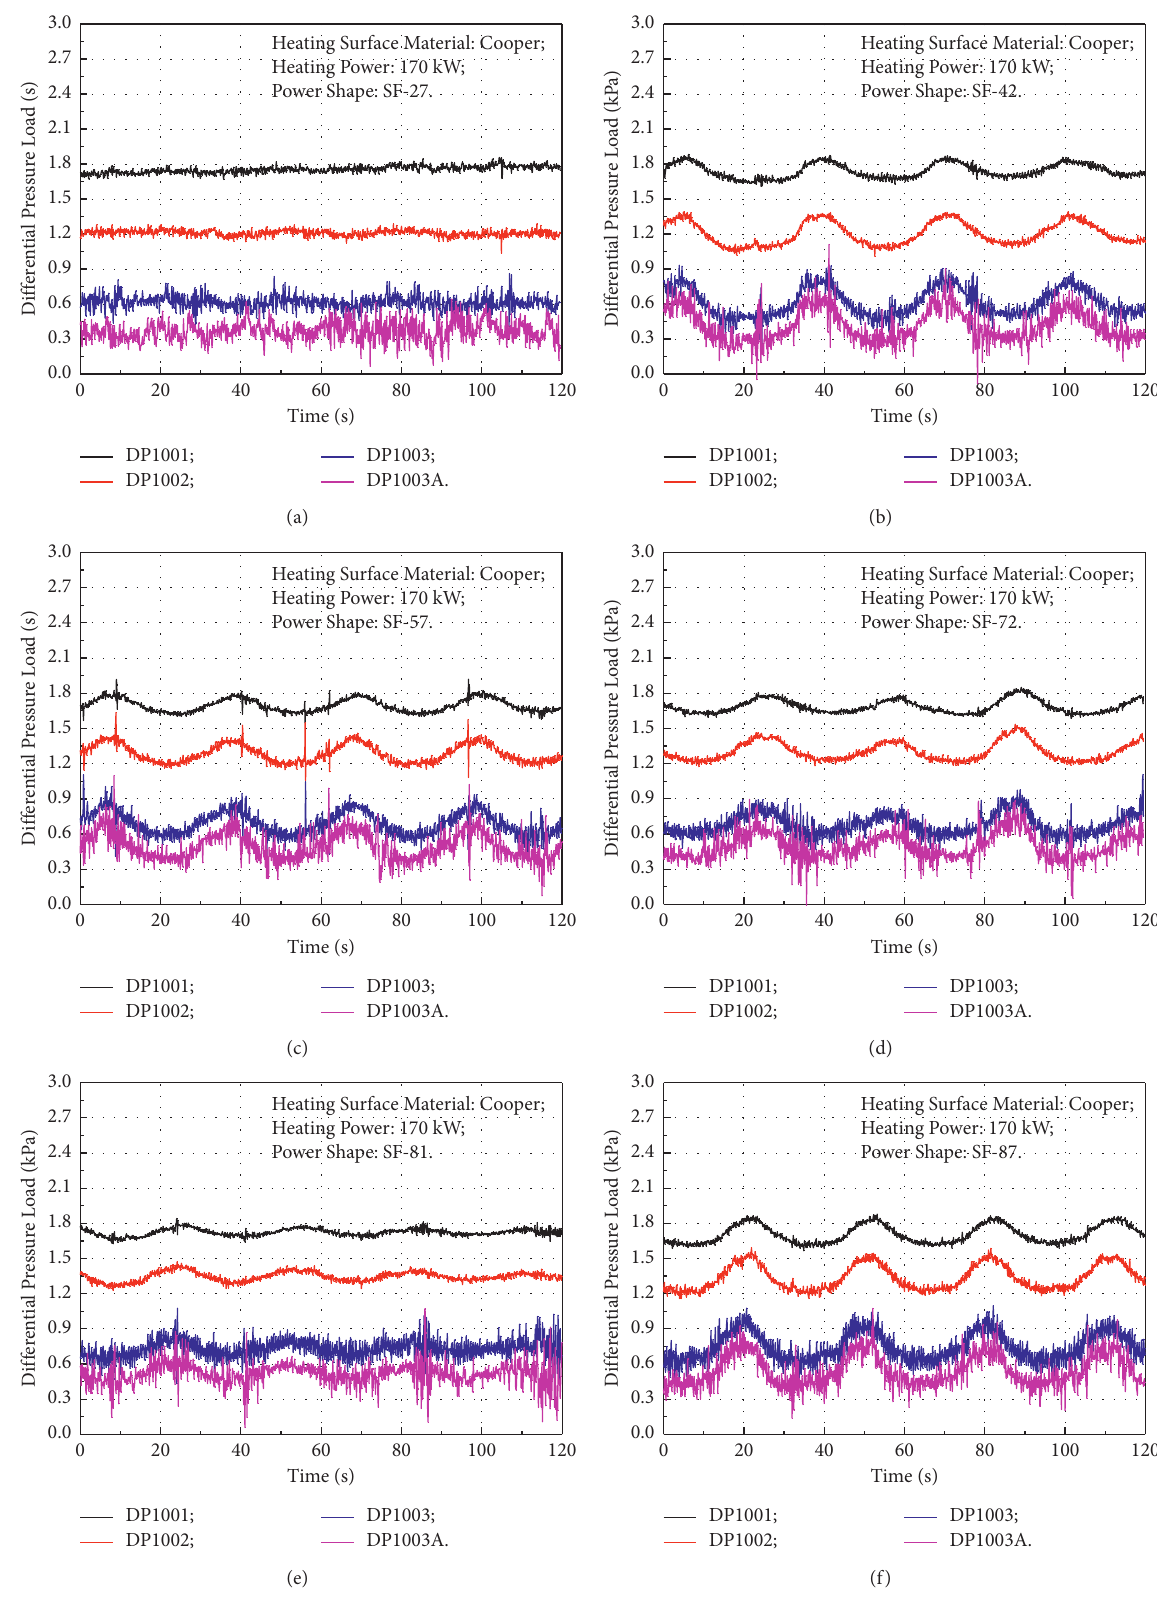
Figure 9: Pressure drops when P � 170 kW . (a) SF-27. (b) SF-42. (c) SF-57. (d) SF-72. (e) SF-81. (f) total